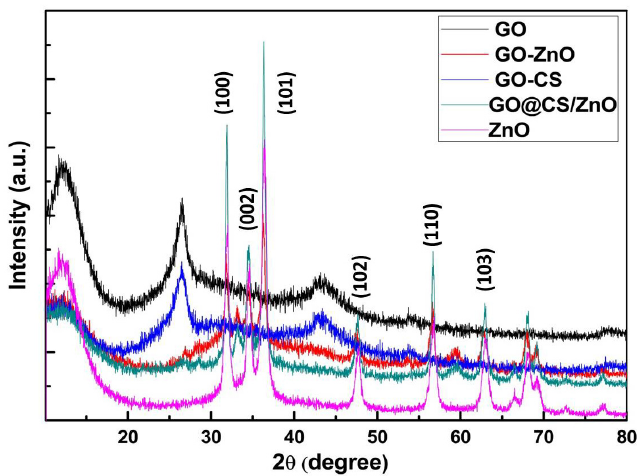
Figure 2. XRD patterns of GO, GO/ZnO, GO–CS, GO–CS/ZnO, and ZnO.